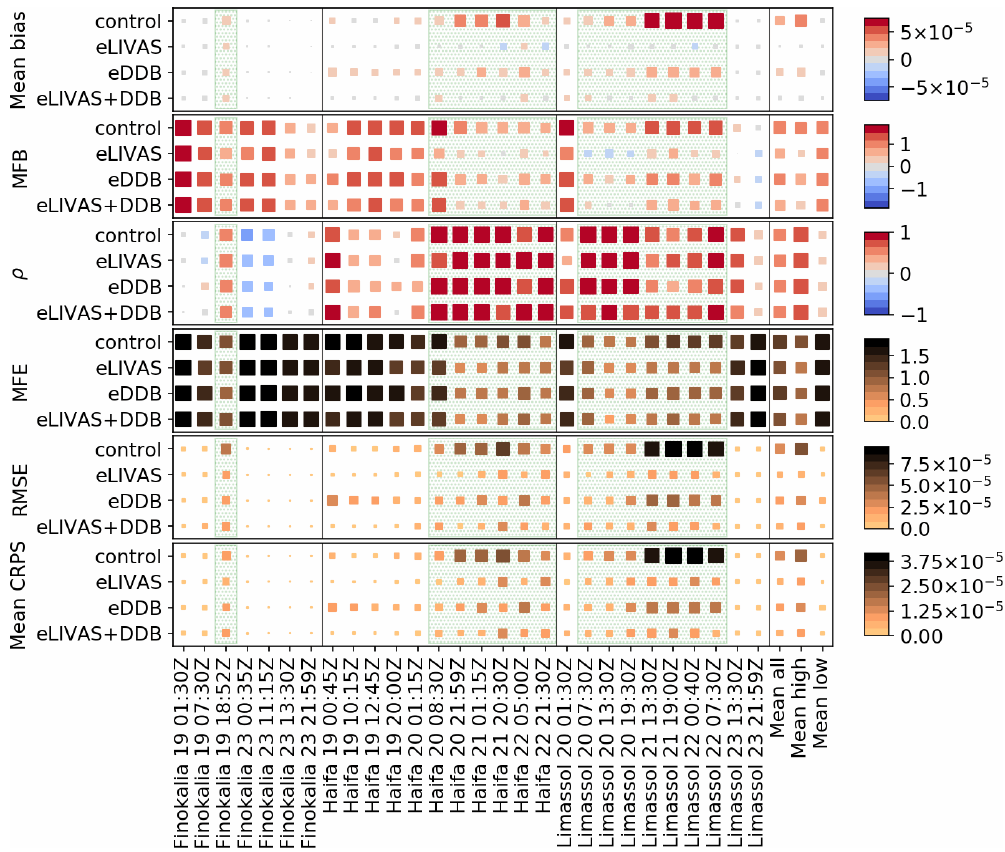
Figure 9. Verification scores of the model analyses for the dust extinction coefficient profiles against measurements of PollyNET lidars of Fig. 7. Mean bias, RMSE, and CRPS have units of m − 1 . Profiles with high values of extinction are shown with a green shade. The last three columns show averages of the scores for the non-shaded profiles (mean low), for the shaded profiles (mean high), and for all profiles (mean all). The areas of the squares are proportional to their values (in